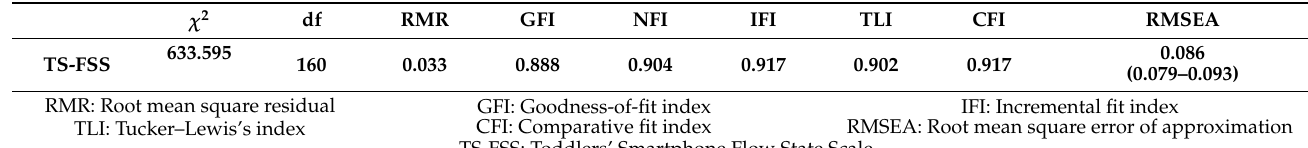
Table 4. Fit indices of TS-FSS in the confirmatory factor analysis ( n = 400).